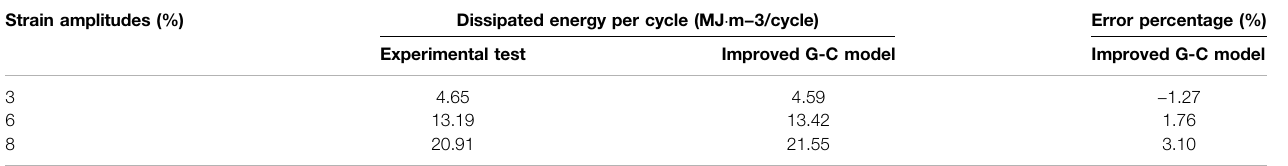
TABLE 2 | Comparison results at various strain amplitudes. Strain amplitudes